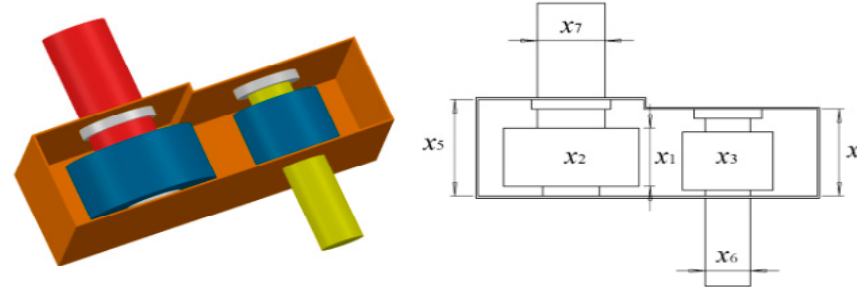
Figure 11. Schematic diagram of speed reducer design.